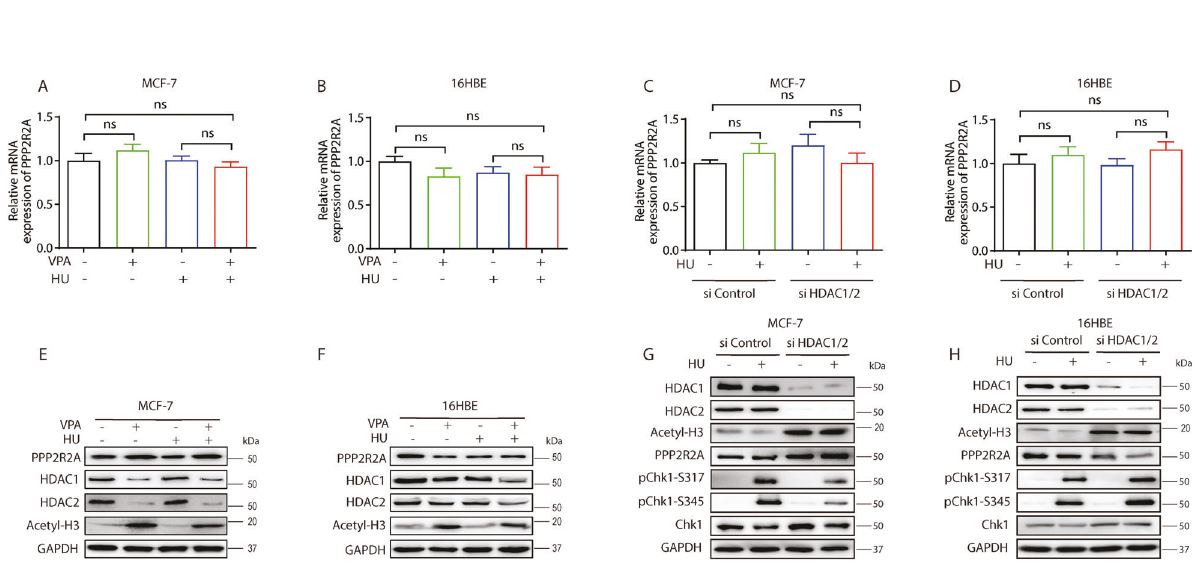
Fig. 7 VPA bidirectionally regulates PPP2R2A at the post-transcriptional level by inhibiting HDAC1/2. A , B Relative mRNA levels of PPP2R2A in MCF-7 and 16HBE cells after exposure to 0.5 mM VPA and/or 2 mM HU was evaluated by quantitative RT-PCR. C , D MCF-7 and 16HBE cells transfected with two independent HDAC1 and HDAC2 targeting siRNAs were treated with 2 mM HU and cells were collected for quantitative RT-PCR. E , F MCF-7 and 16HBE cells were treated as stated in A . Whole-cell lysates were subjected to Western blotting analysis and probed with PPP2R2A, HDAC1, HDAC2 and Acetyl-H3 antibodies. GAPDH was used as loading control. G , H MCF-7 and 16HBE cells were transiently transfected with indicated HDAC1 and HDAC2 targeting siRNAs. After 24 h, cells were treated with 2 mM HU. The protein levels of